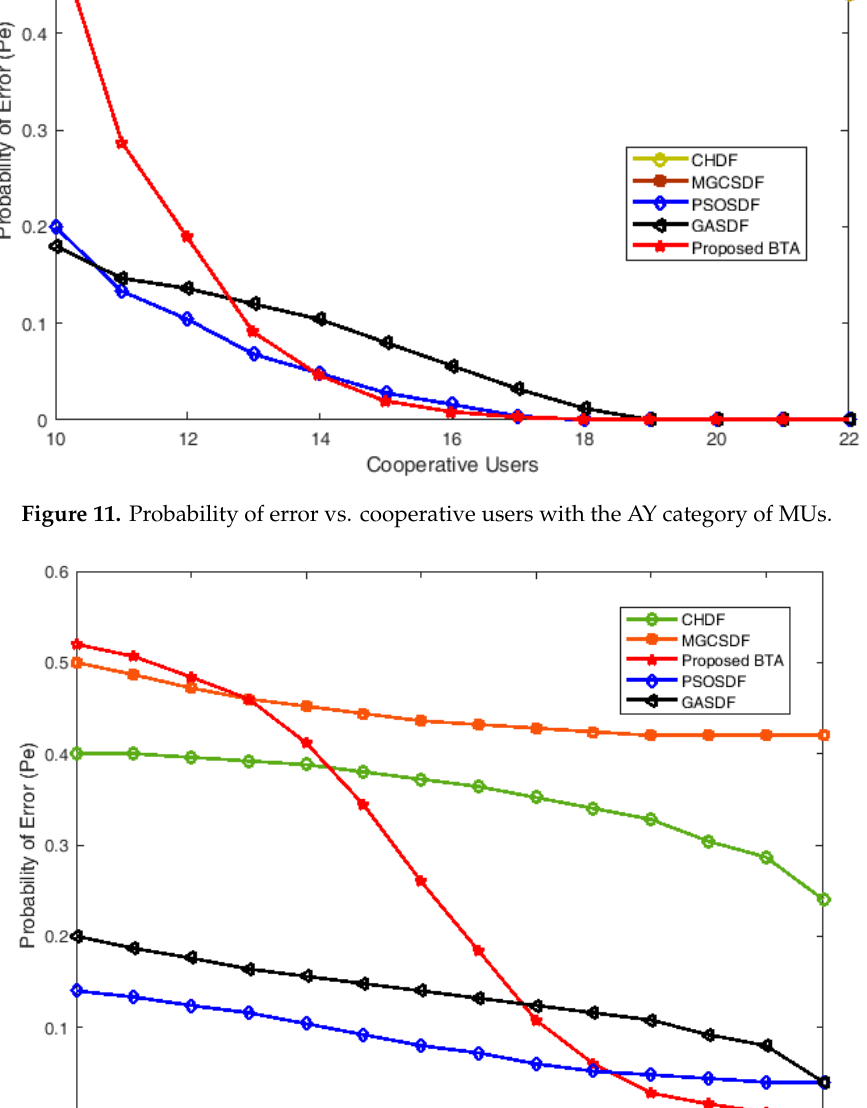
Figure 11. Probability of error vs. cooperative users with the AY category of MUs.